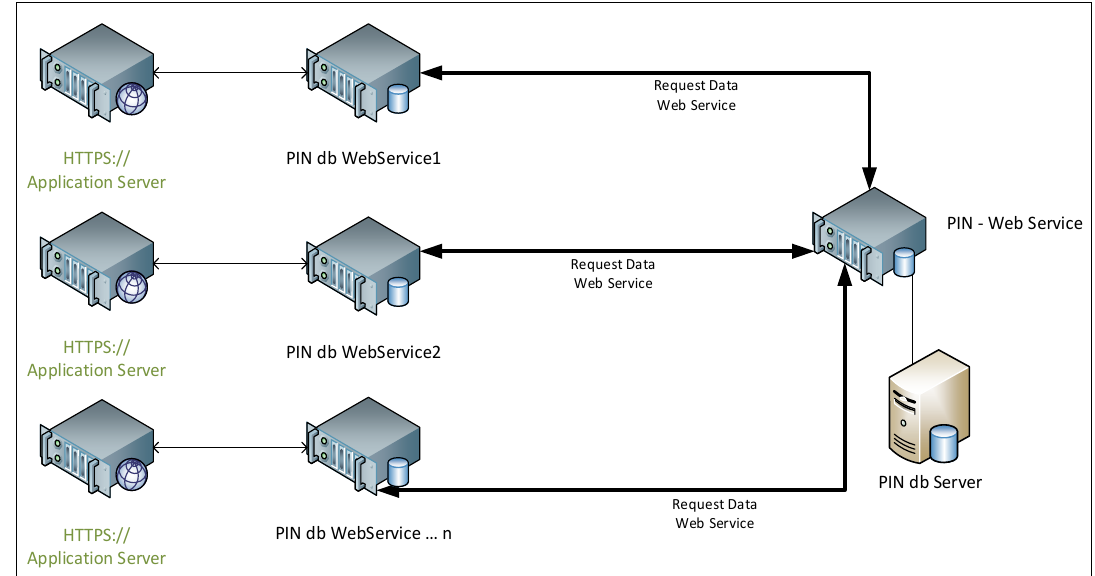
Figure 3. Use of Web Services by consuming personal data from the Civil Status Database, always using security